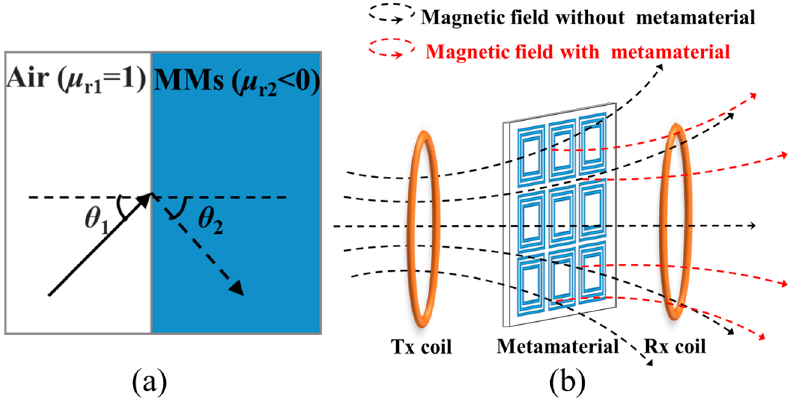
Figure 3. ( a ) Magnetic boundary conditions of the mu-negative-magnetic (MNM) MM. ( b ) Magnetic field without and with metamaterial.